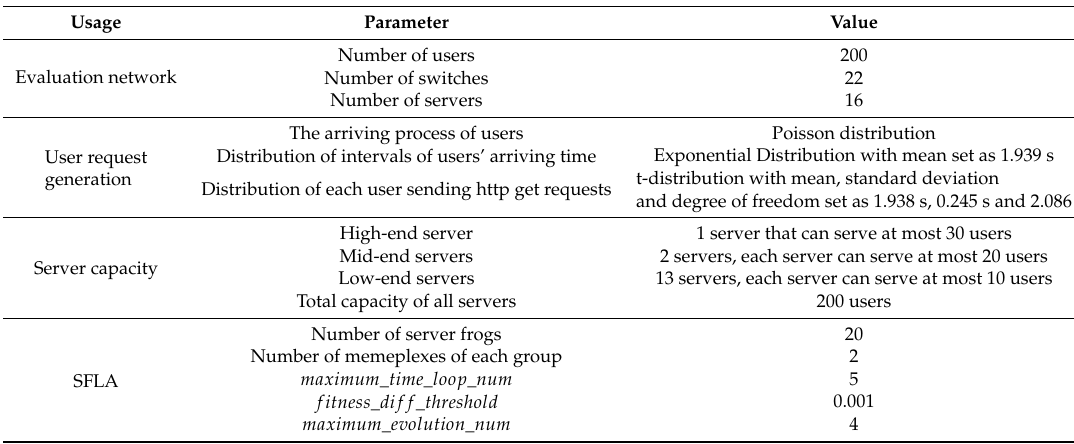
Table 4. Important